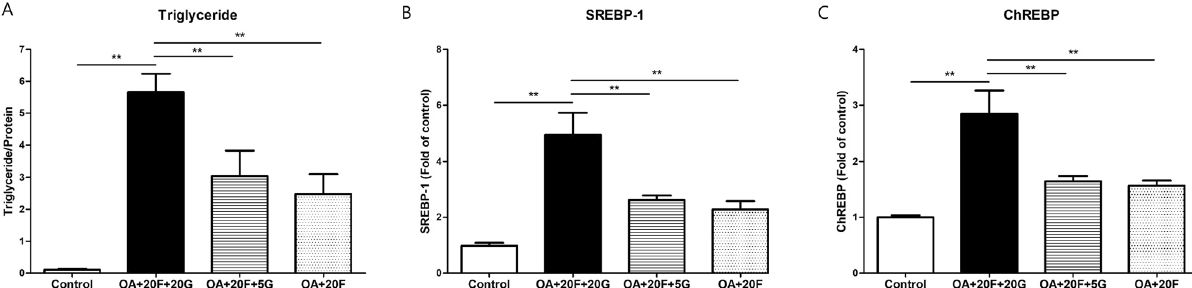
Figure 3. Effects of reduced glucose inflow to hepatocytes on hepatic lipogenesis. ( A ) Hepatic triglyceride level, mRNA expression levels of ( B ) sterol regulatory element-binding transcription factor-1 (SREBP-1) and (C) carbohydrate response element-binding protein (ChREBP). * p < 0.05; ** p < 0.01; OA + 20F + 20G, HepG2 treated with 1.0 mM oleic acid (OA), 20 mM fructose and 20 mM glucose for 48 h; OA + 20F + 5G, HepG2 treated with